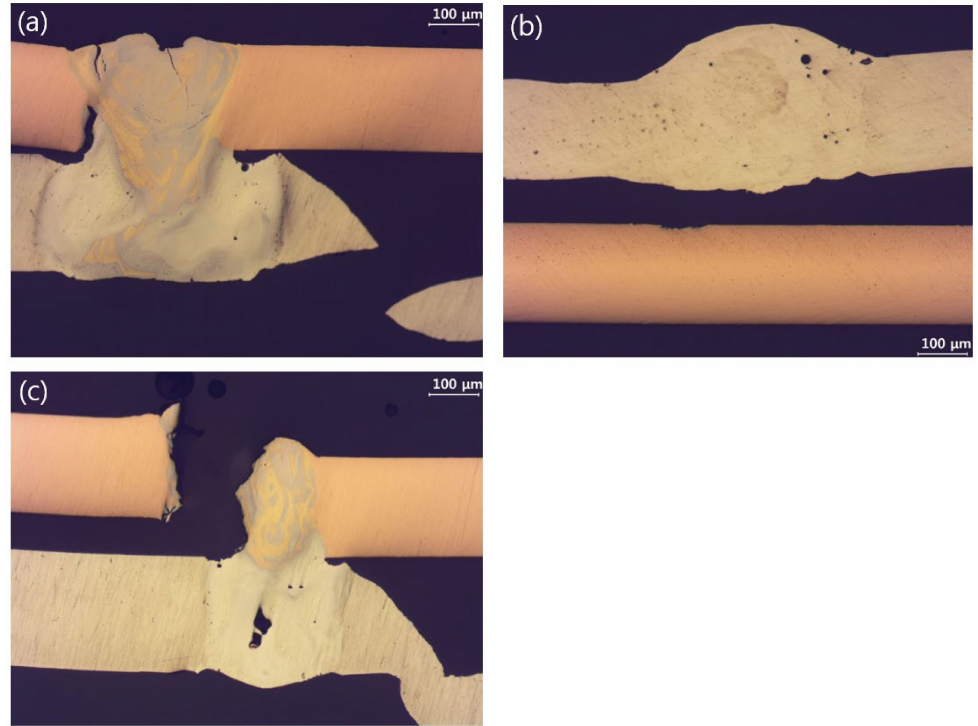
Figure 4. Cross-sectional images of fracture specimens, with fracture formation in ( a ) the Al base metal (Cu-Al, 2 kW, 200 mm/s), ( b ) the joint (Al-Cu, 2 kW, 800 mm/s), and ( c ) the Cu base metal (Cu-Al, 2 kW, 800